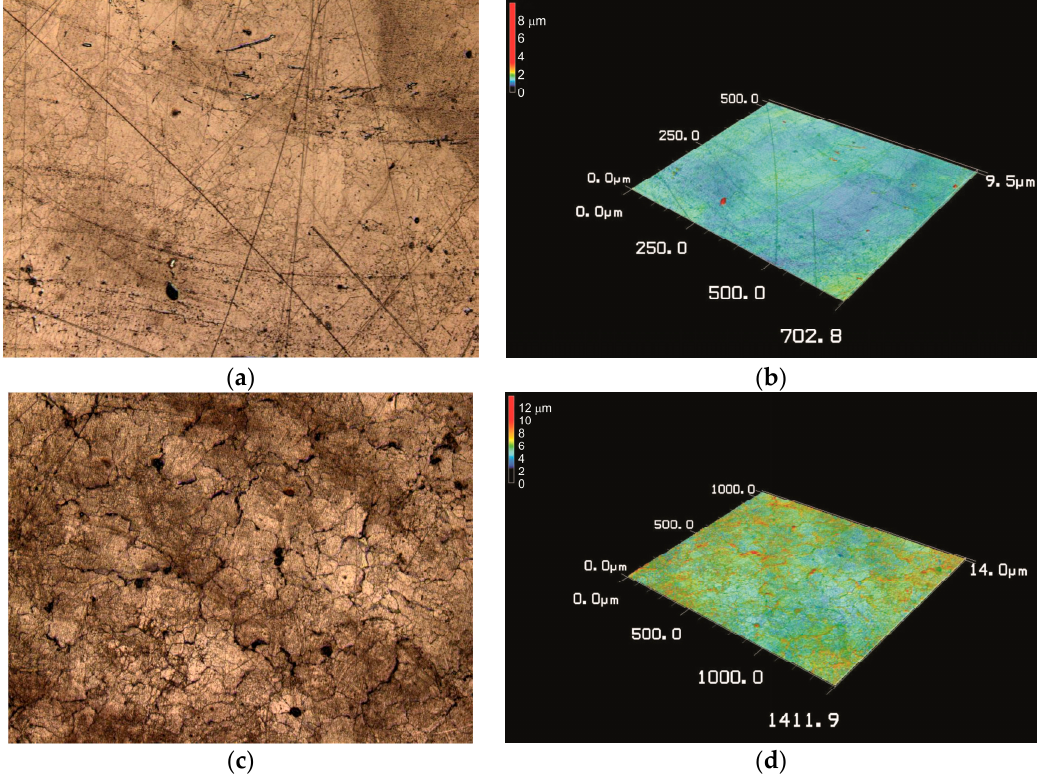
Figure 6. Laser microscope images of the surface of 99.99996% coarse-grained copper and the results of their processing: ( a , b ), non-irradiated; ( c , d ), irradiated. The frame size is ( a , b ), 702.8 × 500 μ m 2 ; ( c , d ), 1411.9 × 1000 μ m 2 ; the height is ( b ) 9.5 μ m, ( d ) 14 μ m.